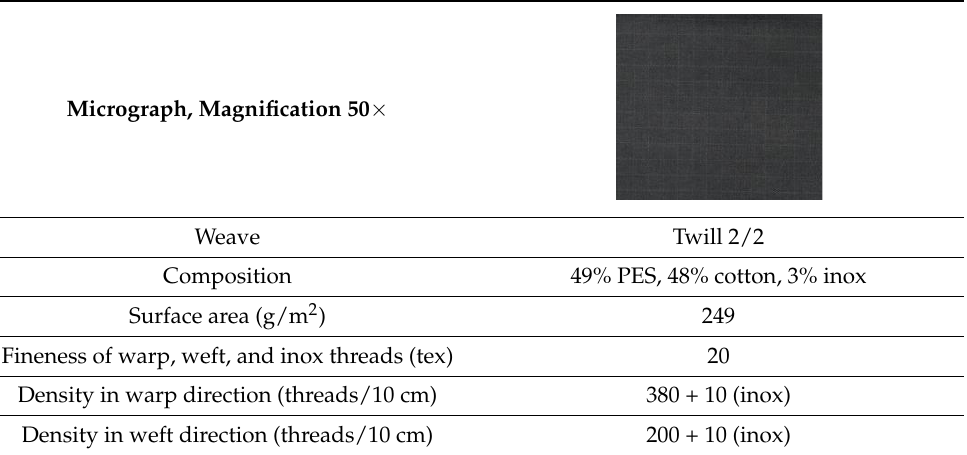
Figure 1. Graphic presentation of thread interlacing for twill fabric. Red = basic warp threads (cotton/PES); Blue = basic weft threads (cotton/PES); Black = effective warp thread (Bekinox); Green = effective weft thread (Bekinox). Table 1. Structural properties of the stainless-steel fabric.